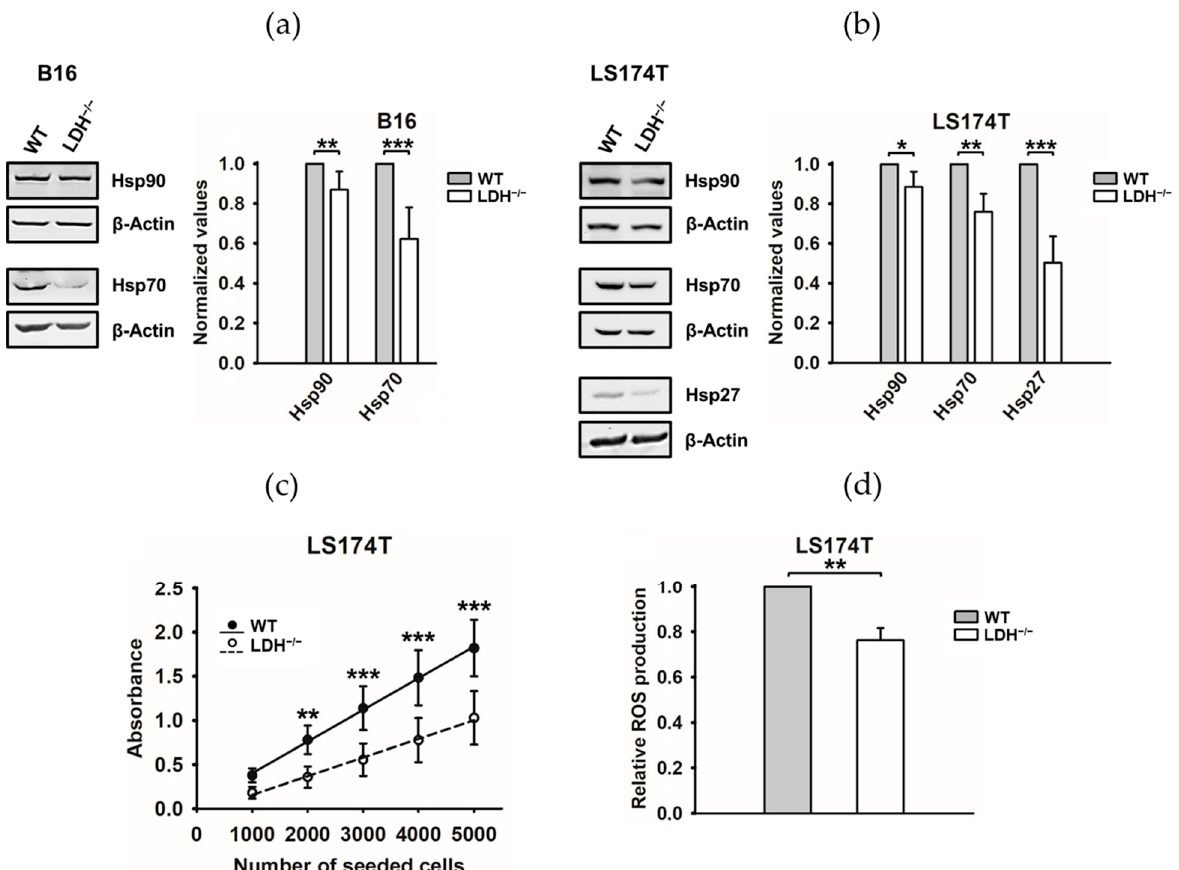
Figure 3. LDHA/B double knockout (LDH − / − ) inhibits the expression of heat shock proteins (HSP) Hsp90, Hsp70 and Hsp27 and inhibits the proliferative activity and reactive oxygen species (ROS) production in tumor cells. ( a,b ) Representative immunoblot showing the expression of intracellular Hsp90, Hsp70 and Hsp27 of B16F10 ( a ) and LS174T ( b ) cells. Quantification of the HSP expression levels are shown in the adjacent bar chart. Error bars show the standard deviations (SD) of at least four biological replicates (*: p ≤ 0.05, **: p ≤ 0.01 and ***: p ≤ 0.001). ( c ) A cell proliferation assay (CCK-8) demonstrated that LDHA/B double knockout inhibited the proliferation in LS174T cells (**: p ≤ 0.01 and ***: p ≤ 0.001). ( d ) The DCFDA assay was used to determine the intracellular ROS levels in LS174T cells, with fluorescence being measured using a microplate reader. Error bars show the SD of four biological replicates (**: p ≤ 0.01). Full Western blot images are available in Figures S6 and S7.